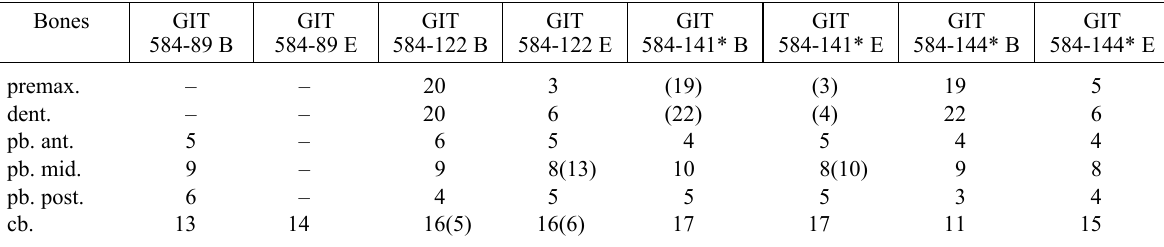
Table 1. Count of teeth on jaws and pharyngeal tooth plates of the European plaice Pleuronectes platessa . The count of tooth sockets or holes is given in parentheses. A dash indicates that no data are available. Abbreviations: ant., anteriormost; cb., ceratobranchial; dent., dentary; mid., middlemost; pb., pharyngobranchial; post., posteriormost; premax., premaxilla; B, blind side; E, eye side; * – specimens from the Norwegian Sea